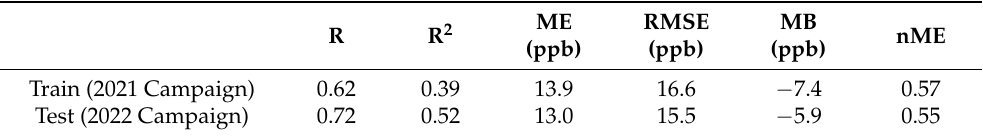
Table 5. Evaluation metrics for the uncorrected ENSENSIA measurements of ozone against the reference. The metrics were calculated based on hourly-averaged values.